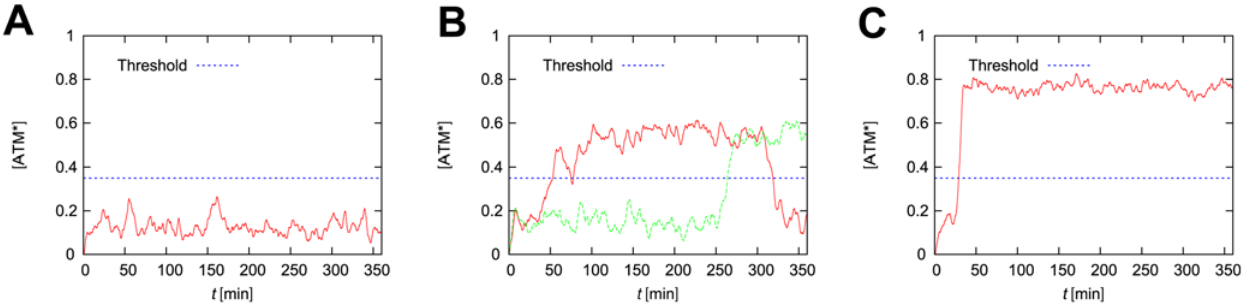
Figure 7. Time courses of the concentration of phosphorylated ATM with the threshold T ATM (cid:2) ~ 0 : 35 . For all figures, the rate constants are j ATM ~ 0 : 78 and k DSB ~ 0 : 0023 . The solid-red lines indicate the time courses. The dashed-blue lines indicate the transition threshold. (A) ATM